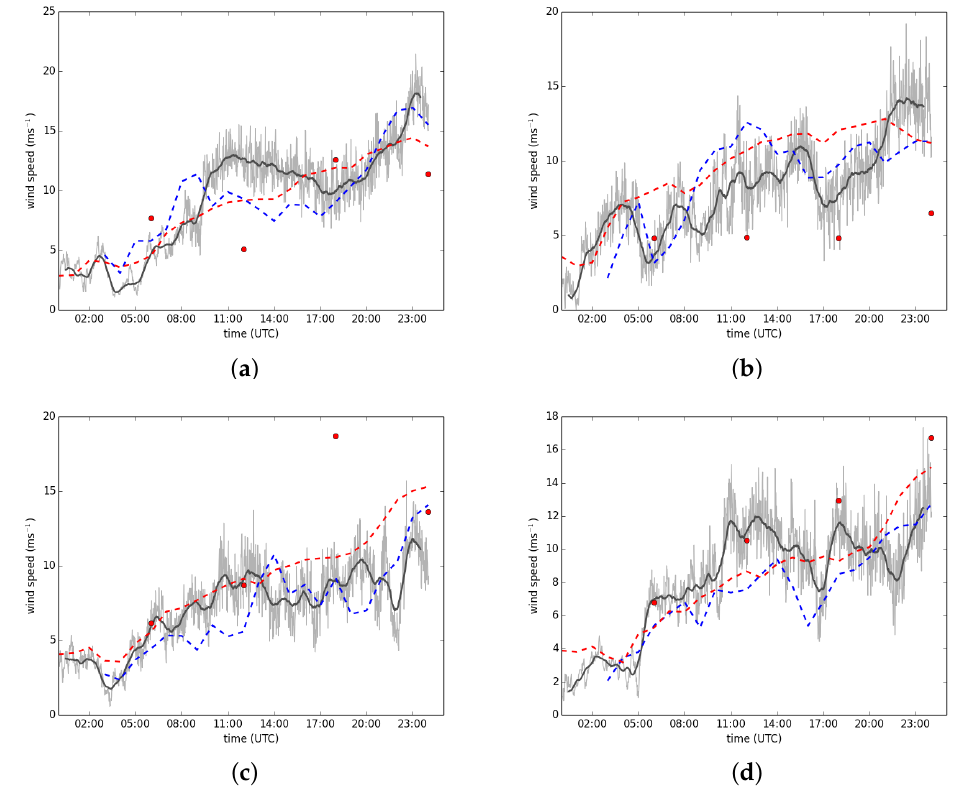
Figure 9. Time series of 10-m winds observed on 6 March 2015 at four Met Office synoptic stations at 1-min intervals (light grey) and as a moving average over 1 h (dark grey) and forecast hourly (instantaneous values) by UKV (blue dashed) and the Met Office global model (red dashed) and six-hourly by 3DVOM (red filled circles) in the grid box containing the same site: ( a ) Tain Range; ( b ) Tulloch Bridge; ( c ) Kinloss; and ( d ) Lossiemouth; locations marked in Figure